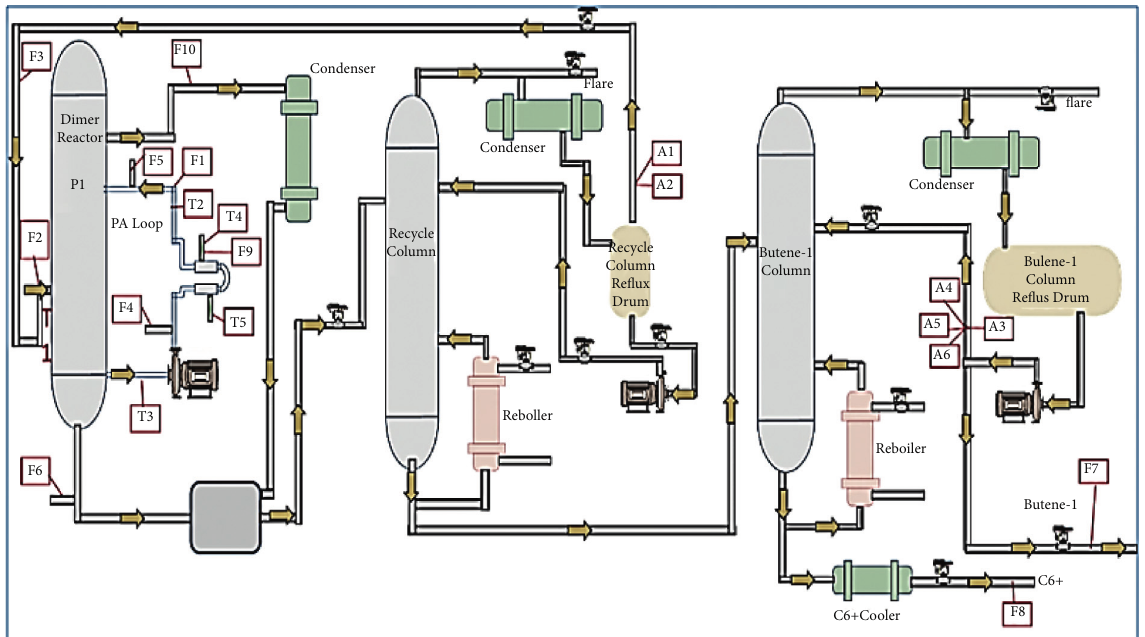
Figure 1: Alphabutol ® schematic process flow diagram. Table 1: The transmitters as well as the range and calibration